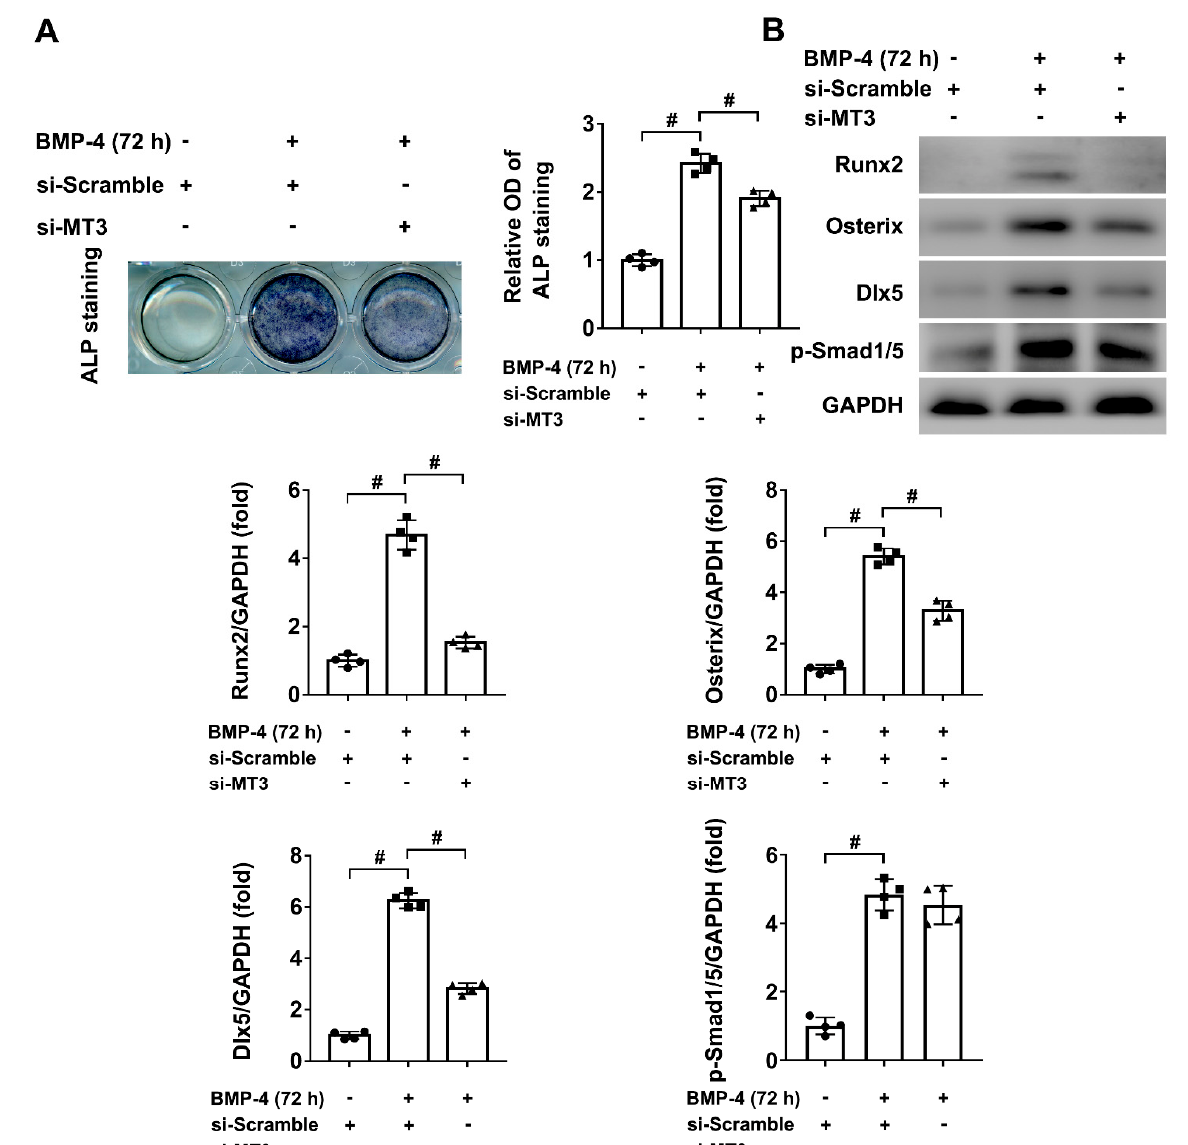
Figure 3. MT3 knockdown inhibited BMP4-induced osteoblast differentiation in C2C12 cells. ( A ) ALP staining and quantitative analysis of ALP activity in control or MT3 knockdown C2C12 cells treated with or without recombinant BMP4 for 72 h. ( B ) Protein expression levels and quantitative analysis of Runx2, Osterix, and Dlx5 in control or MT3 knockdown C2C12 cells treated with or without recombinant BMP4 for 72 h (GAPDH was served as the loading control). All data are presented as mean ± SEM, # p <